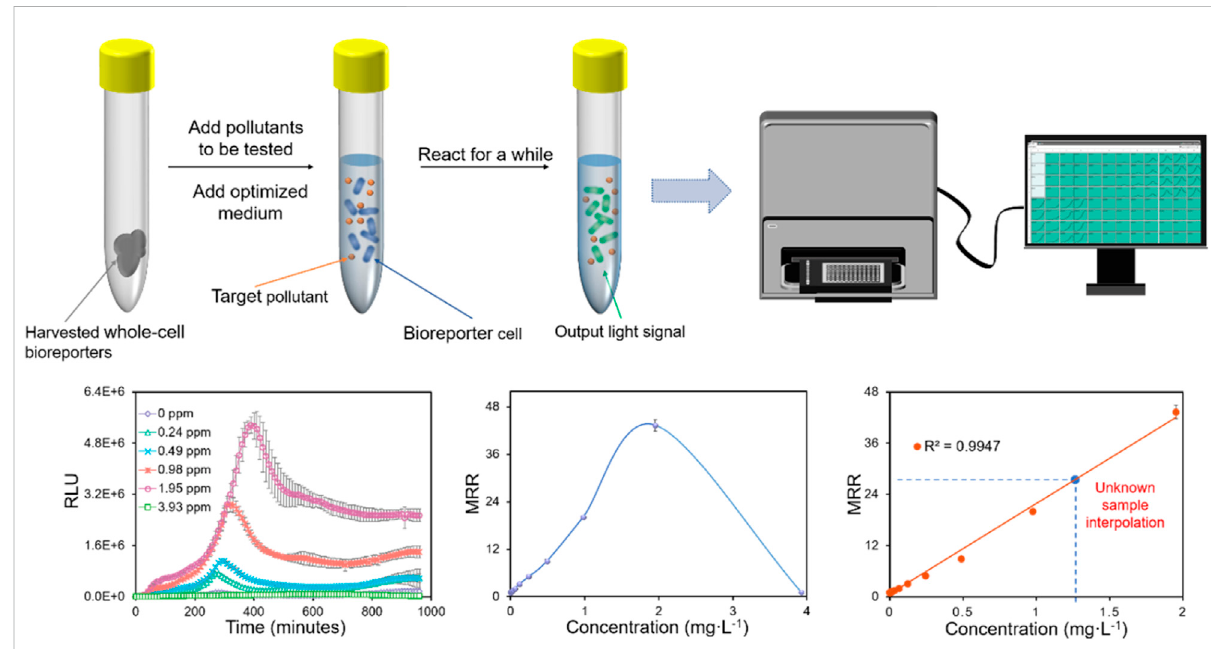
FIGURE 2 Inthespeci fi cexperimentalprocess,thebioluminescencesignalintensityisanalyzedby fi ttingthecurveunderdifferentconcentrationsortime periods of the pollutants to be tested (taking Zn as an example, unpublished